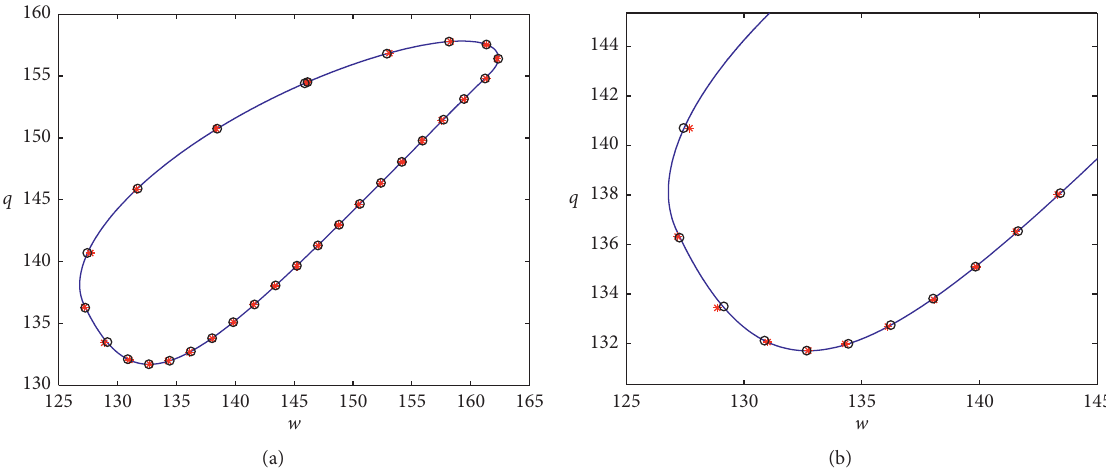
Figure 5: The phase portraits are displayed in (a) and (b), where the solid blue line represents the numerical result, red ∗ is the result of the 6th-order HB-AFT method, and black ° is the result of the 15th-order HB-AFT method. (b) is the local magnification of (a).